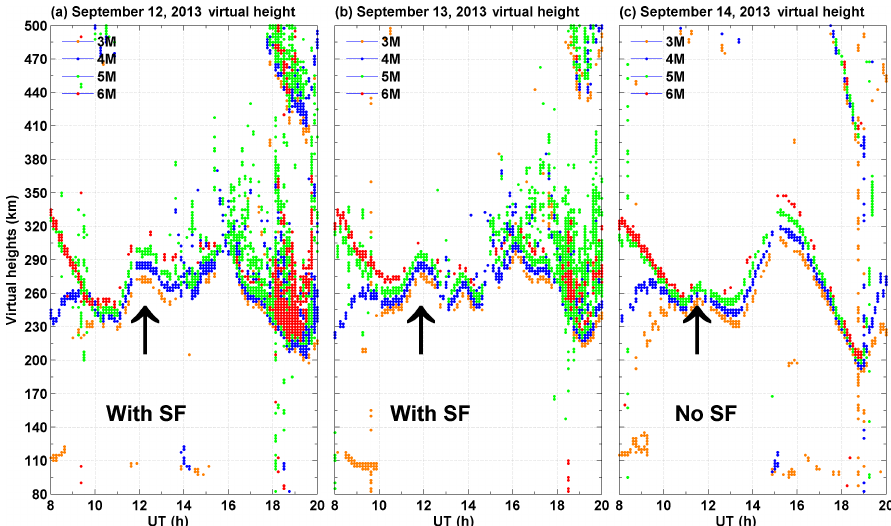
Figure 3. The variations in virtual height at 3, 4, 5 and 6MHz frequencies (isofrequency plots) from 08:00 to 20:00UT on 12–14 Septem- ber 2013 observed by DPS-4D over Sanya with SF (a, b) and with no SF (c) . The black bold arrows mark the uplift of the virtual heights by the PRE during post-sunset